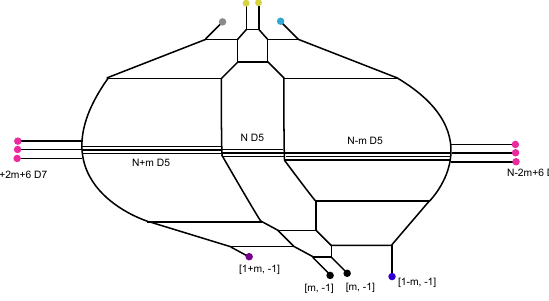
X [1+ m; 1] [1 m; 1] (cid:0) (cid:0) X 7-branes. [1+ m; 1] [1 m; 1] (cid:0) (cid:0)